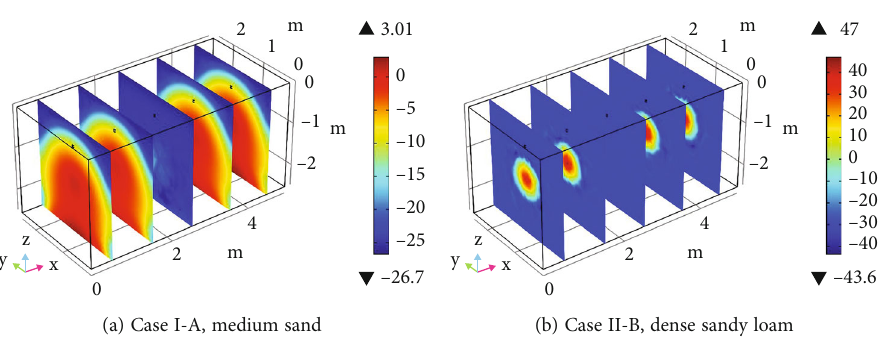
Figure 7: Pressure distribution after 1hr of